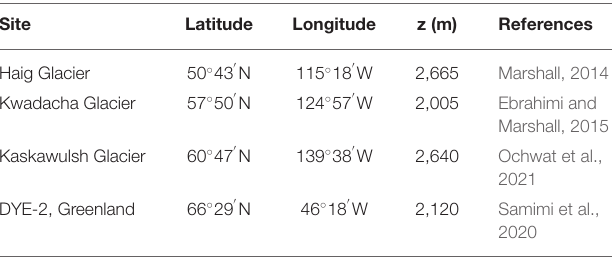
TABLE 1 | Field sites drawn from in the analyses of glacier-climate regime changes. Site Latitude Longitude z